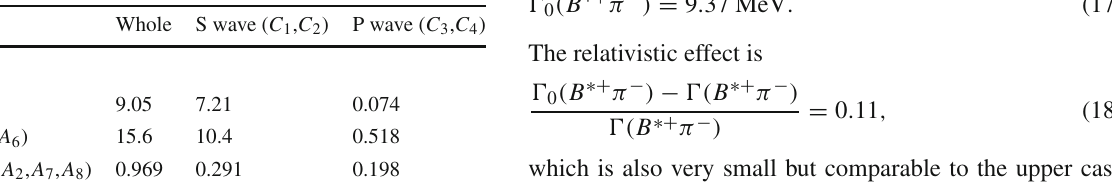
Table2 Decaywidths(MeV)ofdifferentpartialwaves,where“whole”